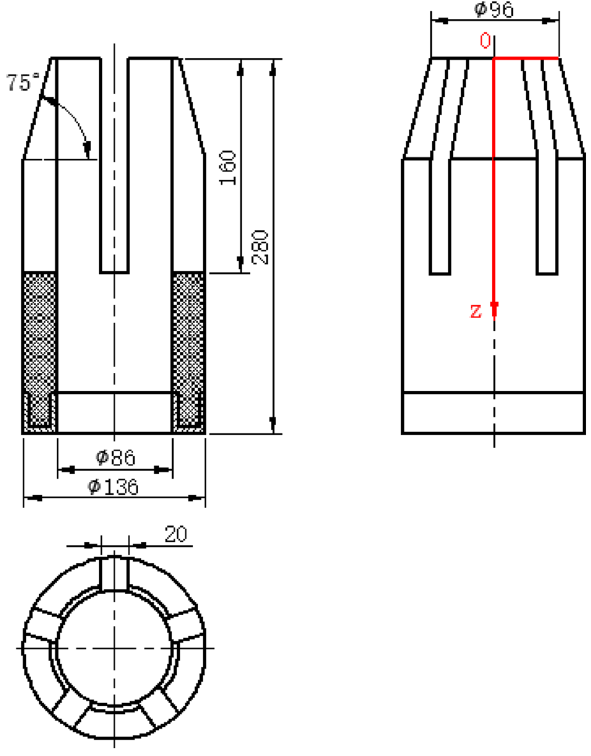
Fig. 7 Structure diagram of high-temperature sealed rubber